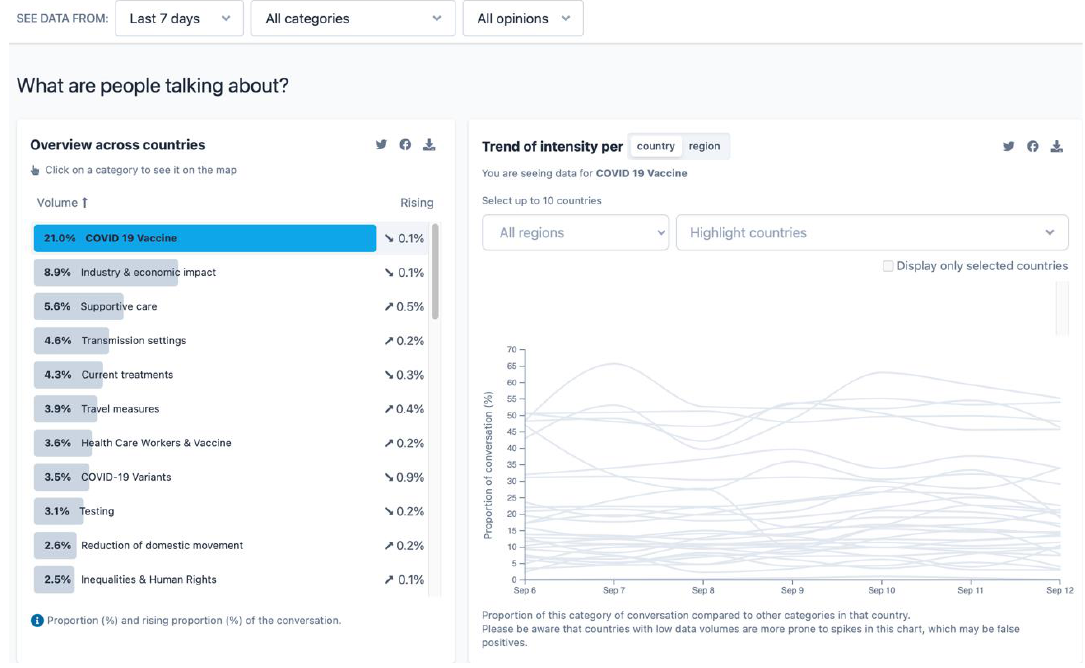
It does not include state, regional, or community-level